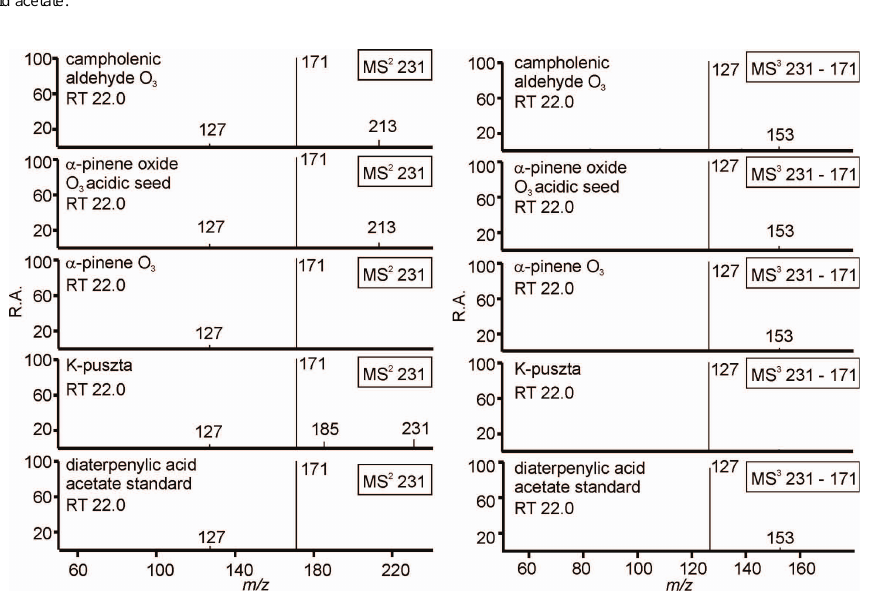
Atmos. Chem. Phys., 14, 719–736,